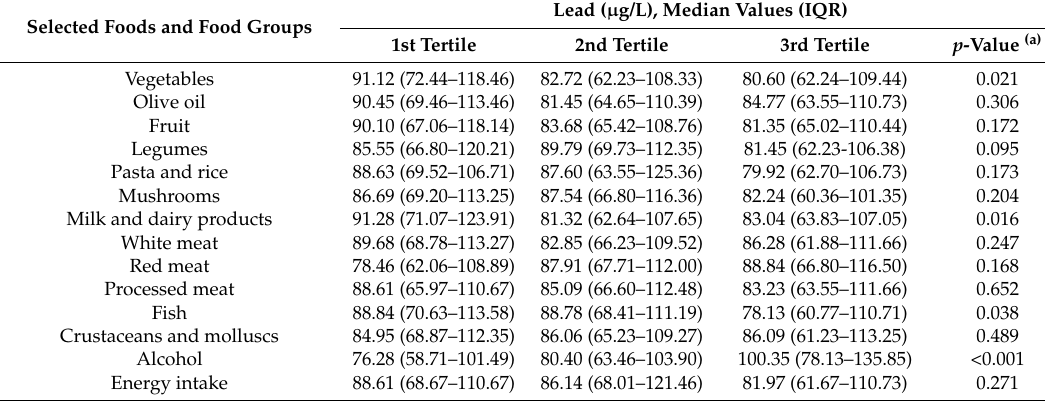
Table 2. Erythrocyte lead levels ( µ g/L) according to the consumption of selected foods and food groups. Selected Foods and Food